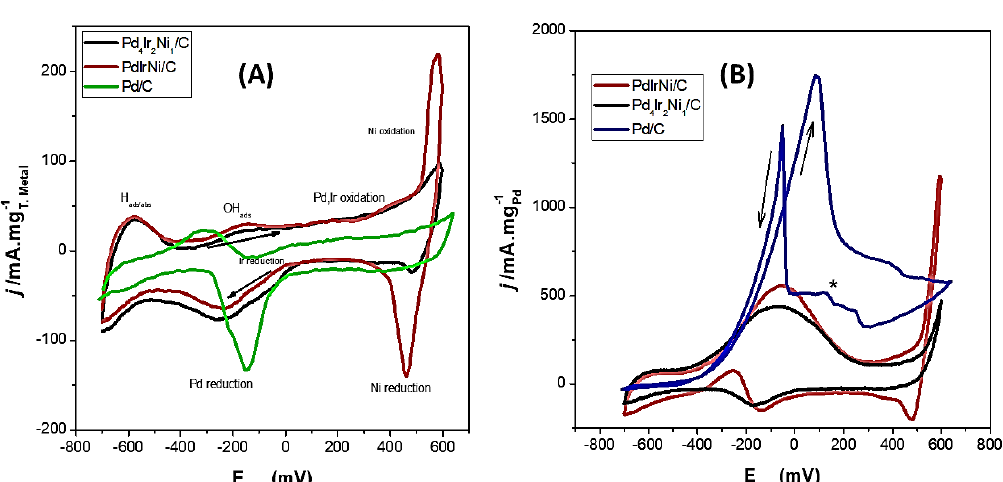
Figure 7. Cyclic voltammetry (CV) of Pd/C, PdIrNi/C, and Pd 4 Ir 2 Ni 1 /C in 1M KOH at 50 mV/s vs. NHE in 1M KOH ( A ) and 1M KOH + EtOH ( B ) (*) unknown peaks.